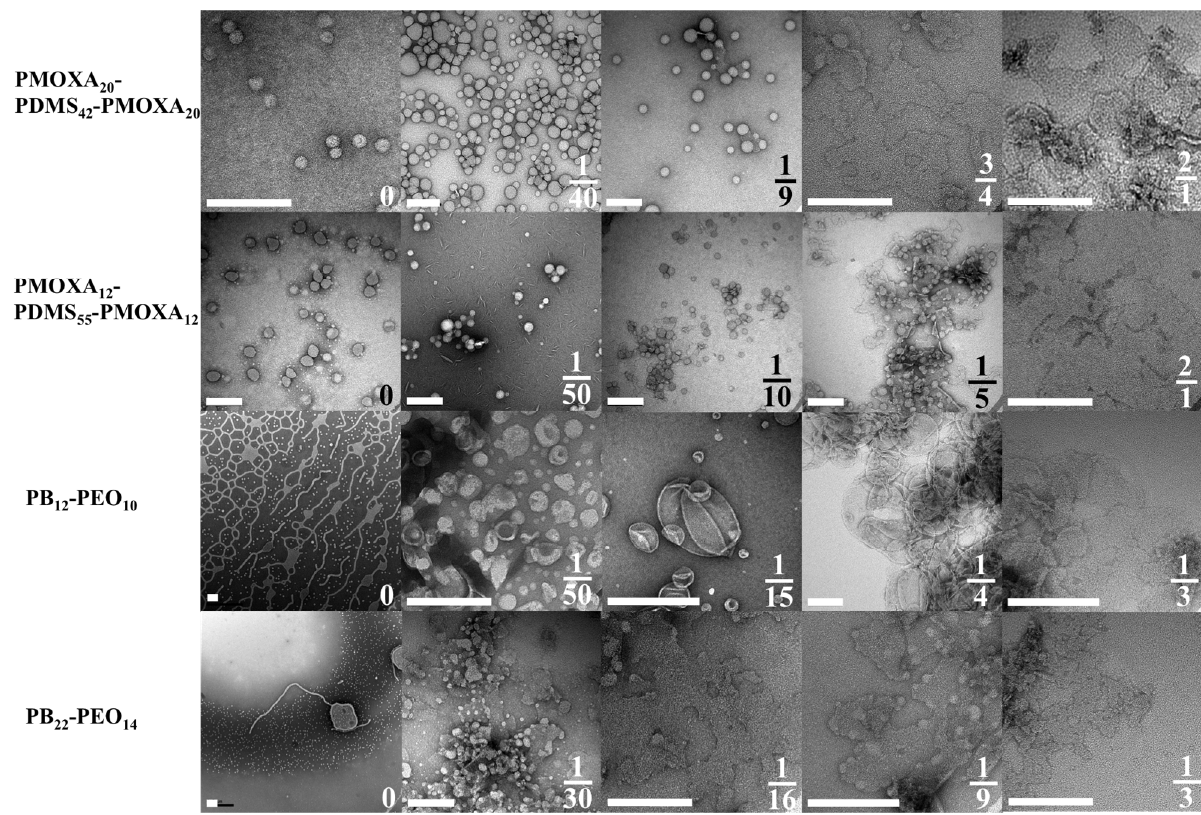
Figure 2. TEM images of aggregate morphologies as a function mPAR.